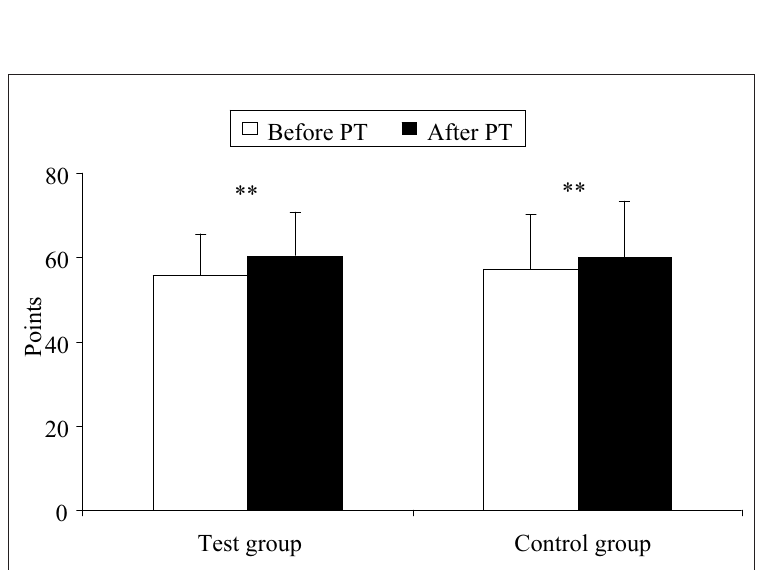
Figure 5. Changes in gross motor function measurements by general scale in the